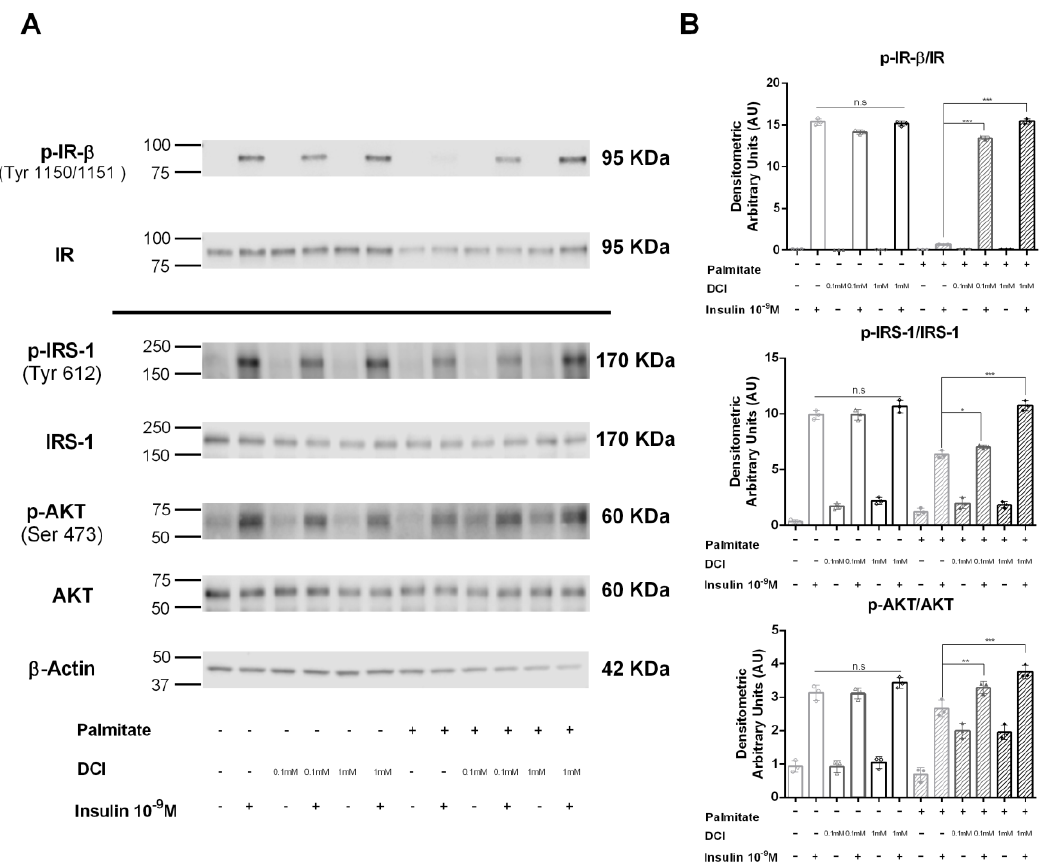
Figure 5. E ff ect of DCI on insulin receptor (IR) phosphorylation and the IRS-1 / AKT pathway in α -TC1-6 cells exposed to palmitate. Immunoprecipitation and Western blot analysis for total IR (Tyr1150 / 1151- β subunit) (p-IR- β ) and total IR; Western blot analysis for p-IRS-1 (Tyr612), total IRS-1 (IRS-1), p-AKT (Ser 473), total AKT (AKT), and β -actin: α TC1-6 cells were treated with DCI (0.1 or 1 mM for 48 h) in the presence or absence of palmitate (0.5 mM for 48 h) and acutely stimulated with insulin (10 − 9 M for 5 min). ( A ) Representative immunoblot of three independent experiments. ( B ) Means ± SEM of densitometric analysis. One-way ANOVA followed by Bonferroni test ( n = 3) was used to evaluate statistical significance in insulin-stimulated cells treated with increasing concentrations of DCI with respect to insulin-stimulated controls in the absence and presence of palmitate: * p < 0.05, ** p < 0.01, *** p < 0.001. n.s., not significant; DCI, D-chiro-inositol.